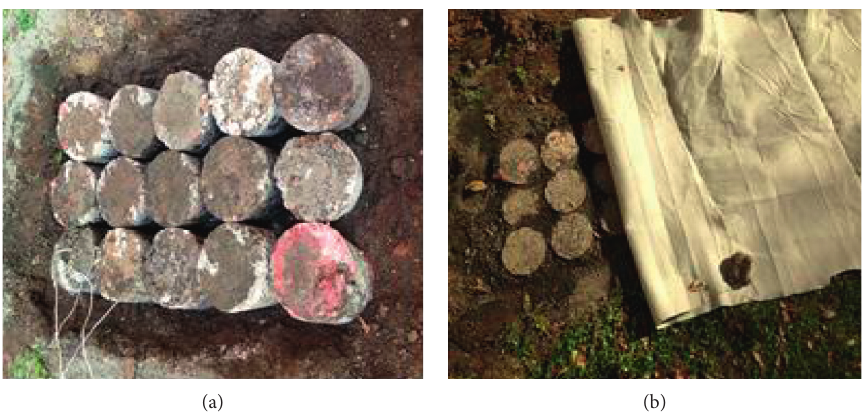
Figure 4: Specimen placement pictures. (a) Specimens were placed into pit. (b) Gap was filled and covered with geotextile.